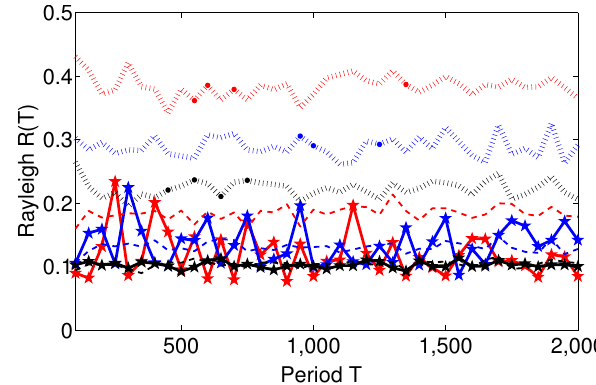
Fig. 7: Rayleigh measures for ice core data (solid lines) shown together with the ensemble means (dashed lines) and upper 2 σ values (dotted lines) in each case. Shown are NGRIP (black), GRIP (red) and GISP2